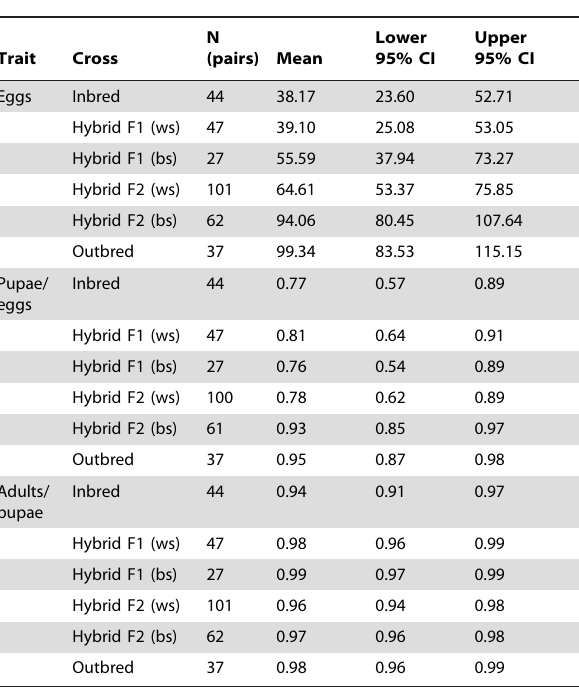
Table 1. Mean breeding values and 95% credible intervals (CIs) for absolute numbers of eggs laid, proportion of eggs that pupated, and proportion of pupae that eclosed for inbred, hybrid, and outbred groups of Drosophila melanogaster (ws: within-strain crosses, bs: between-strain crosses).